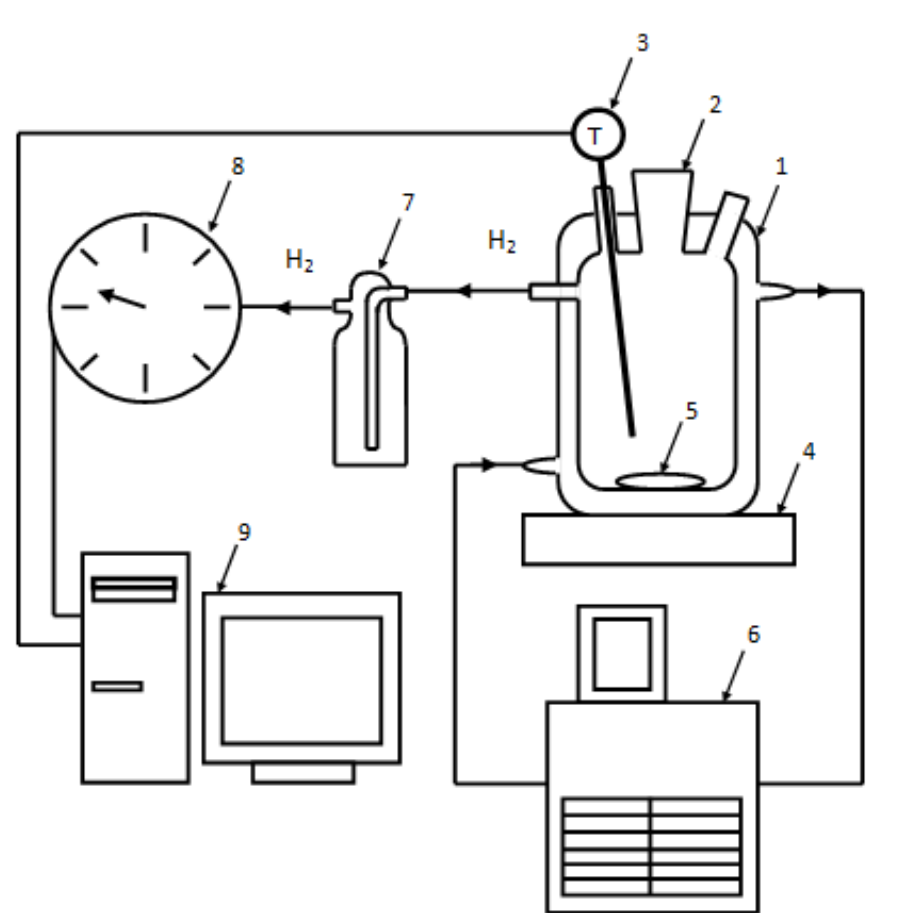
Figure 3. Experimental plant: 1—reactor, 2—filling nozzle, 3—resistance temperature detector, 4— magnetic mixer, 5—stir bar, 6—thermostat, 7—Drexel flask, 8—drum-type gas meter, 9—computer.